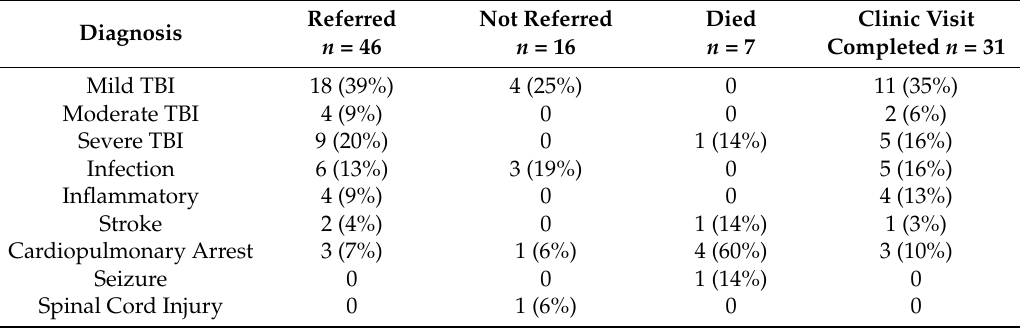
Table 1. Clinic referrals and visits by diagnosis among patients meeting clinic